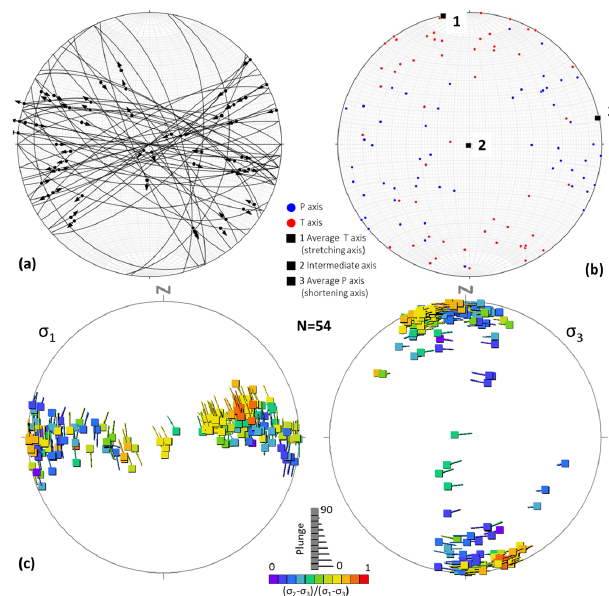
Figure 10. (a) Lower-hemisphere, equal-area projection of the 54 fault planes with kinematic information, showing also the slicken- line attitudes and the sense of movement. (b) Results of the kine- matic analysis for the fault planes are shown in panel (a) . P indi- cates pressure; T indicates tension. (c) Results of the dynamic anal- ysis for the fault planes are shown in panel (a) . Colours represent the (cid:56) value calculated for each stress